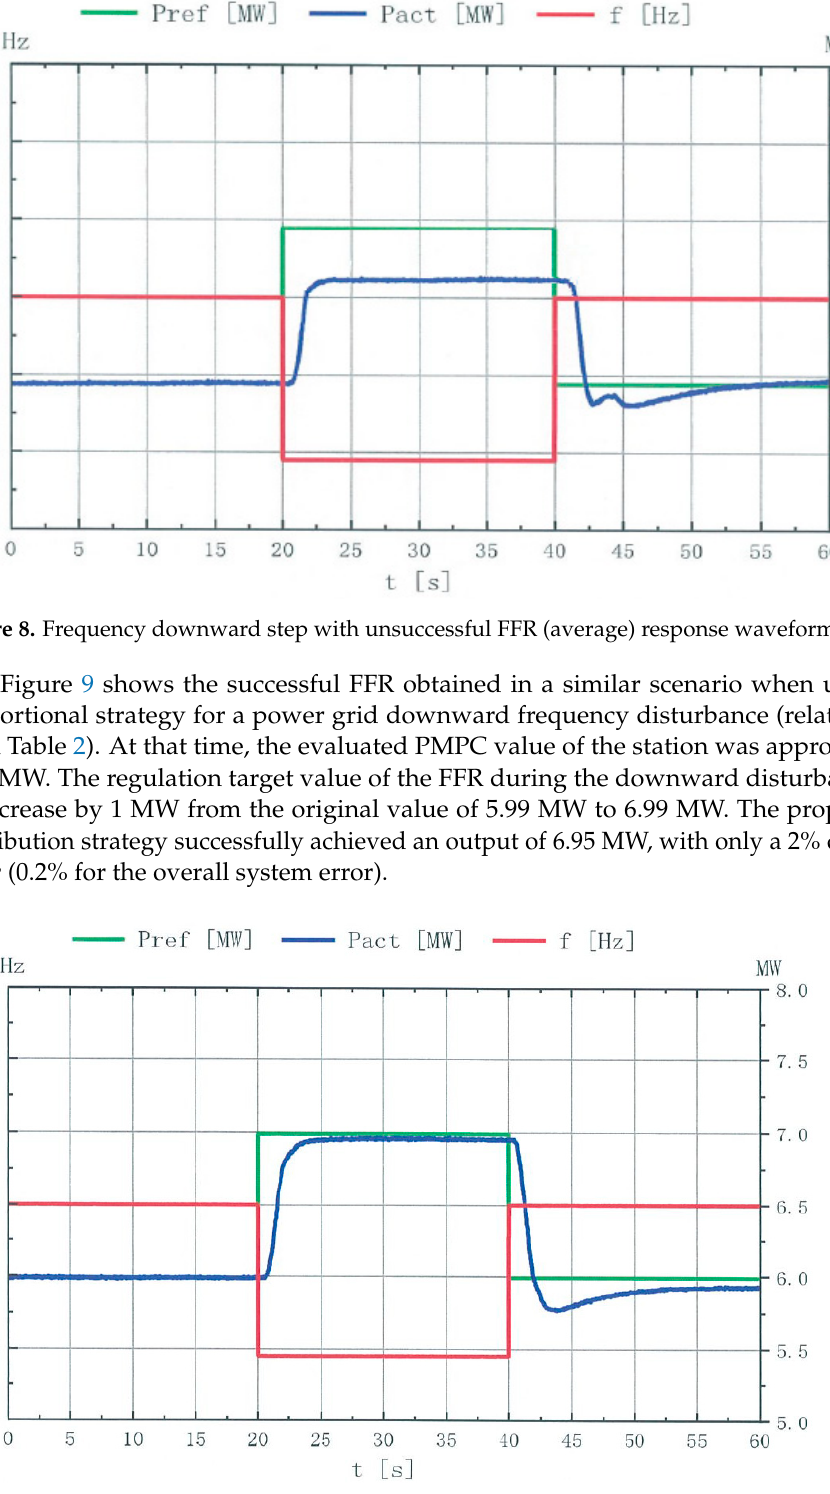
Figure 9. Frequency downward step with successful FFR (proportional) response waveform.